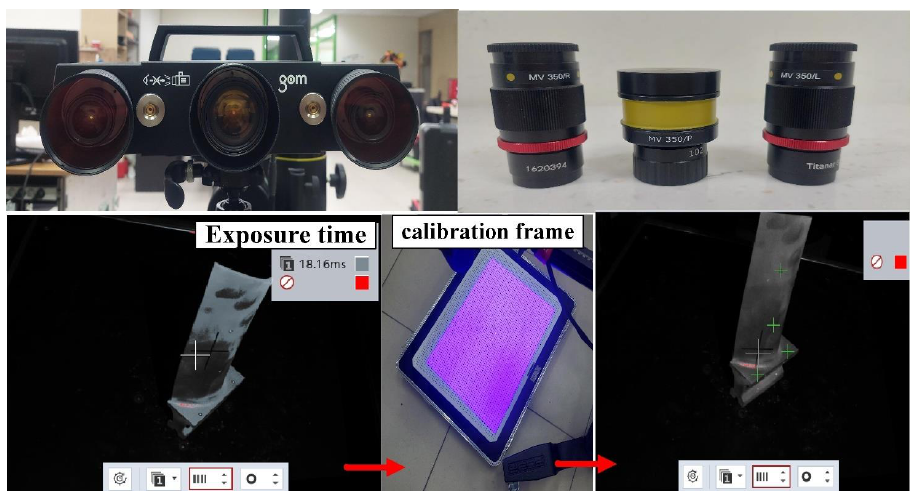
Figure 2. Calibration process before optical measurements.